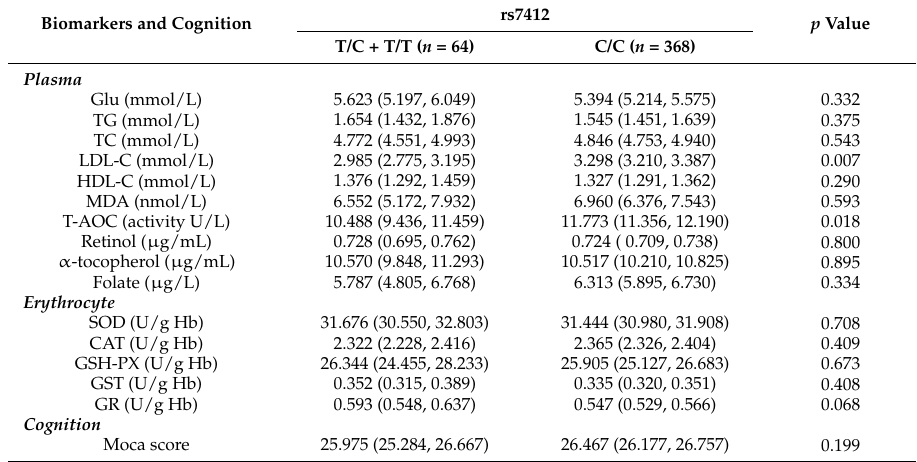
Table 3. Plasma, erythrocytes parameters and cognition according to APOE